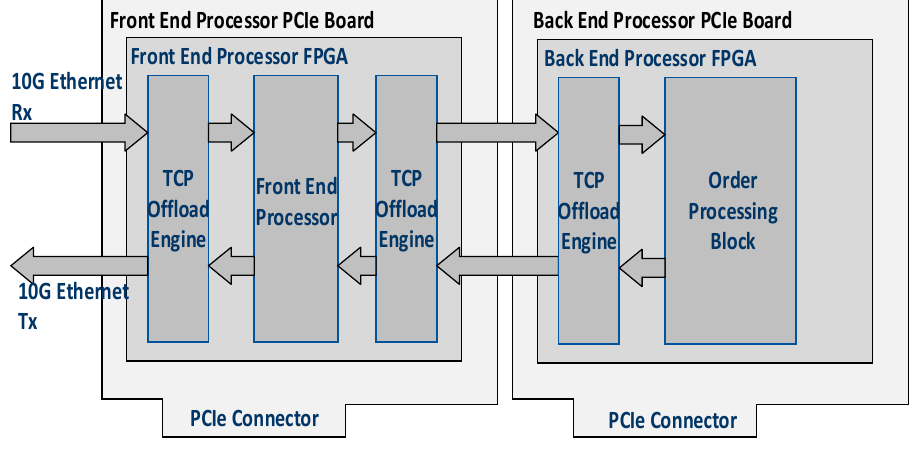
Figure 2. Architecture of the trading system implemented in an FPGA.